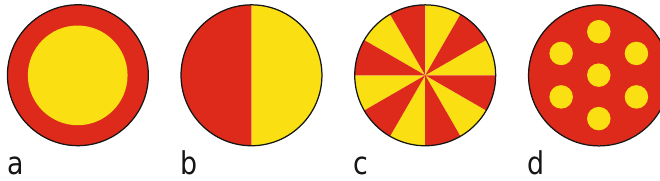
Figure 10. Typical cross-sections of bicomponent fibers: ( a ) core-sheath, ( b ) side-by-side, ( c ) segmented pie, ( d ) islands-in-the-sea. By way of illustration, the two fiber-forming polymers are represented in yellow and red, respectively.